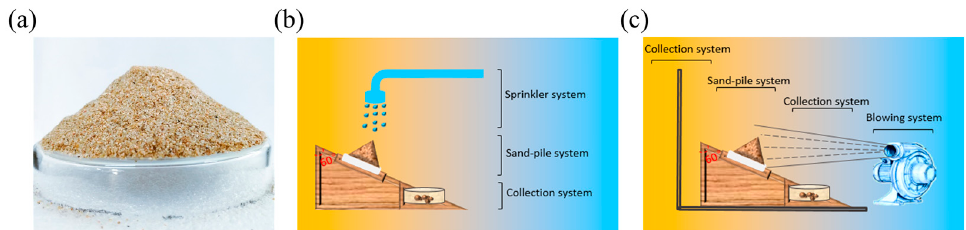
Figure 1. ( a ) Sand column model; ( b ) Device for testing anti-water erosion; ( c ) Device for testing anti-wind erosion.